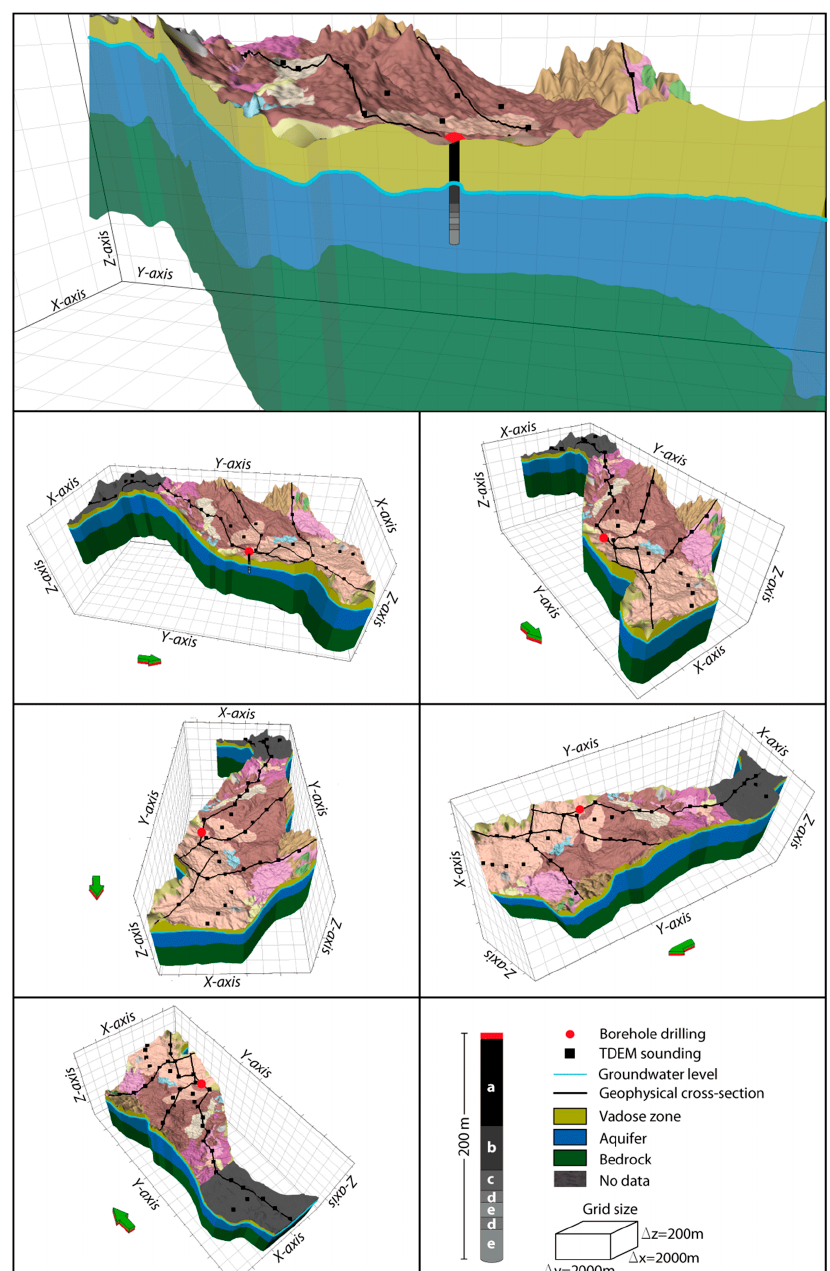
Figure 8. 3D visualization and integration model. ( a ) Vadose zone; ( b ) fractured lava aquifer; ( c ) granular aquifer in andesitic breccia; ( d ) aquitard; ( e ) fractured breccia aquifer. The colors in the uppermost layer refer to lithologies shown in Figure 2.